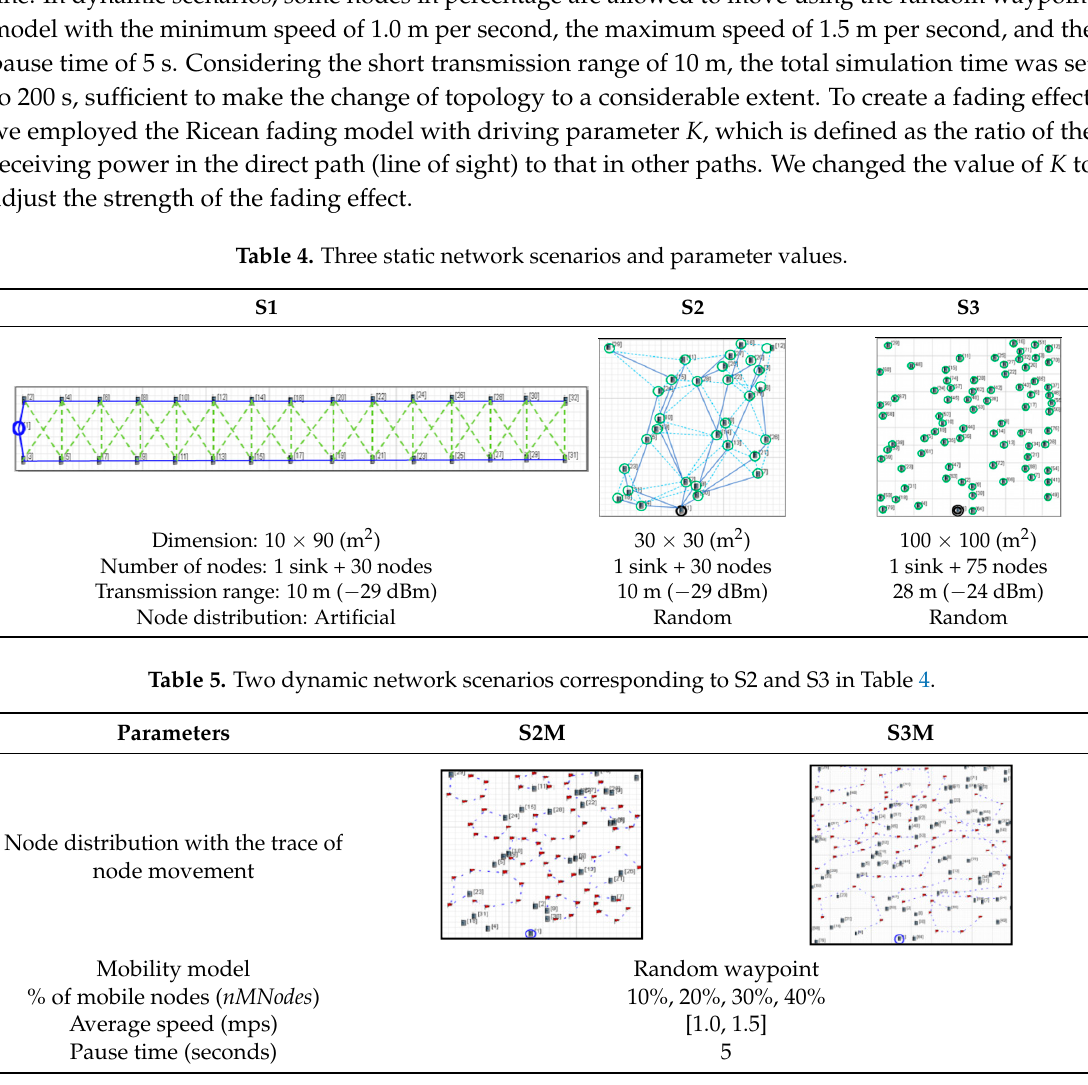
Table 3. Comparisons on the lower bound of E2ED.